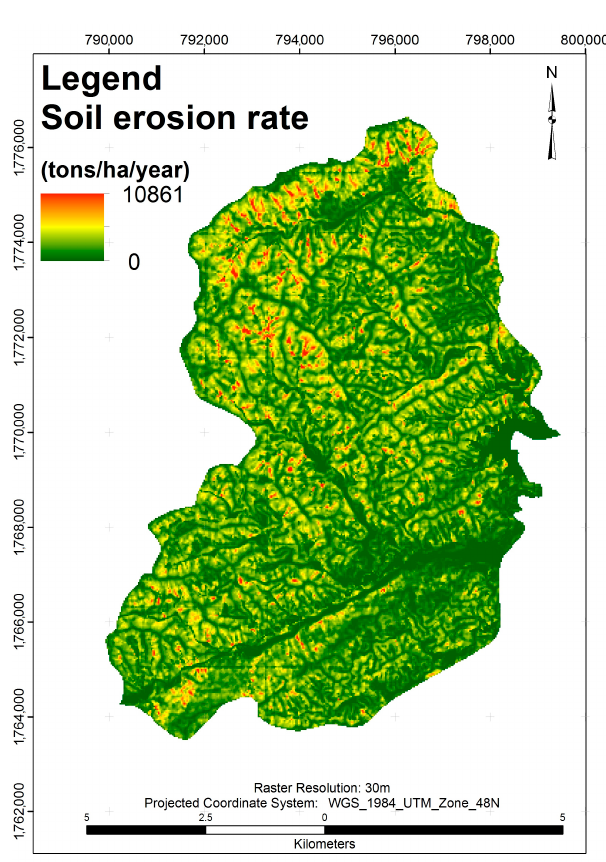
Figure 4. Soil erosion rate using USLE model in Song Kon commune.